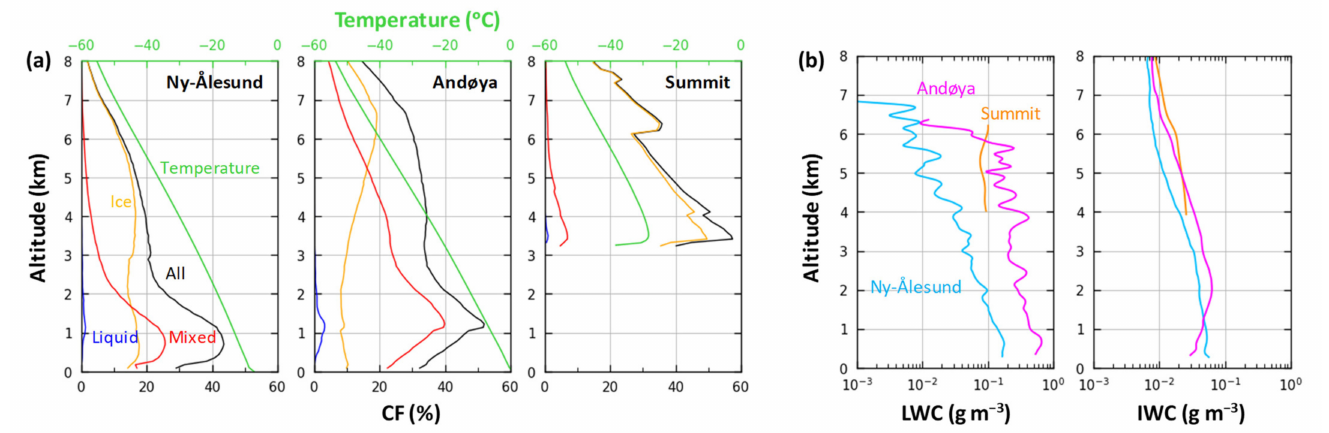
Figure 2. Vertical profiles of the wintertime mean ( a ) CF and ( b ) LWC/IWC at three sites (Ny-Ålesund, Andøya, and Summit) on the Atlantic side of the Arctic. In ( a ), colored line denotes CF of all (black), liquid (blue), ice (yellow), and mixed-phase (red) clouds, respectively, and green line indicates air temperature. In ( b ), LWC and IWC are indicated by sky-blue- (Ny-Ålesund), magenta- (Andøya), and orange- (Summit) colored